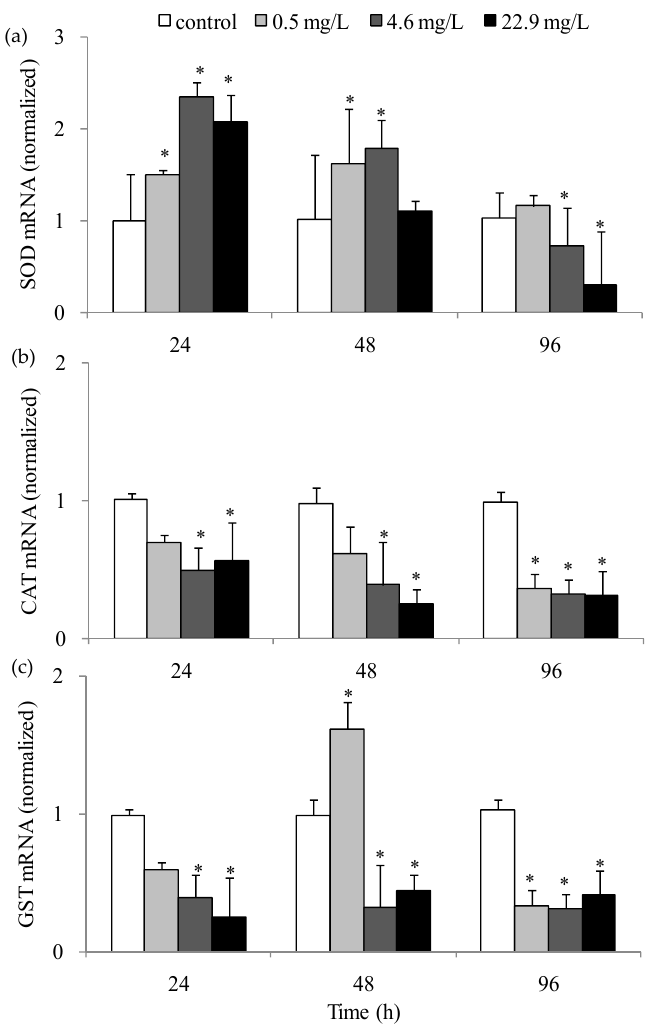
Figure 5. Gene expression level of antioxidant enzyme in zebrafish liver exposed to DMP: ( a ) the SOD gene expression; ( b ) CAT gene expression; ( c ) GST gene expression. Adult fish were treated with 0.5, 4.6 and 22.9 mg / L DMP for 24, 48, and 96 h. Gene expression levels of significance compared to the control are marked with asterisks ( p < 0.05). The error bars represent the standard deviation (n = 5).